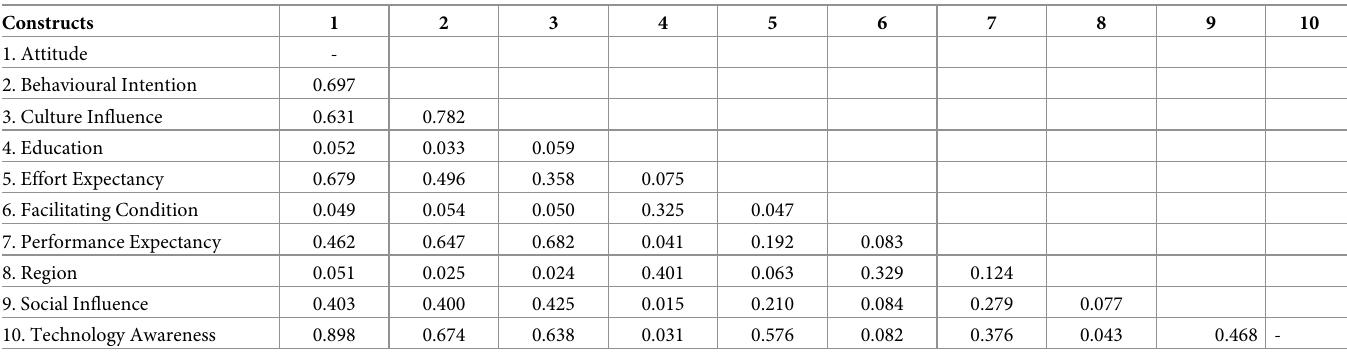
Table 5. Discriminant validity (HTMT criterion).